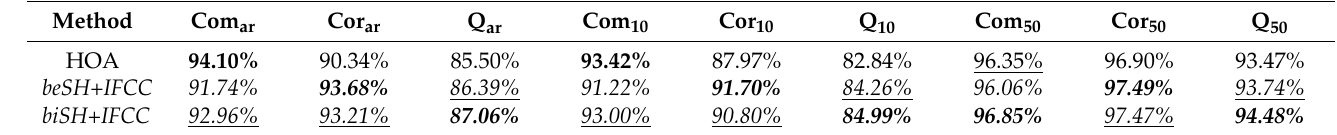
Table 5. Quantitative evaluation results of different methods on the entire